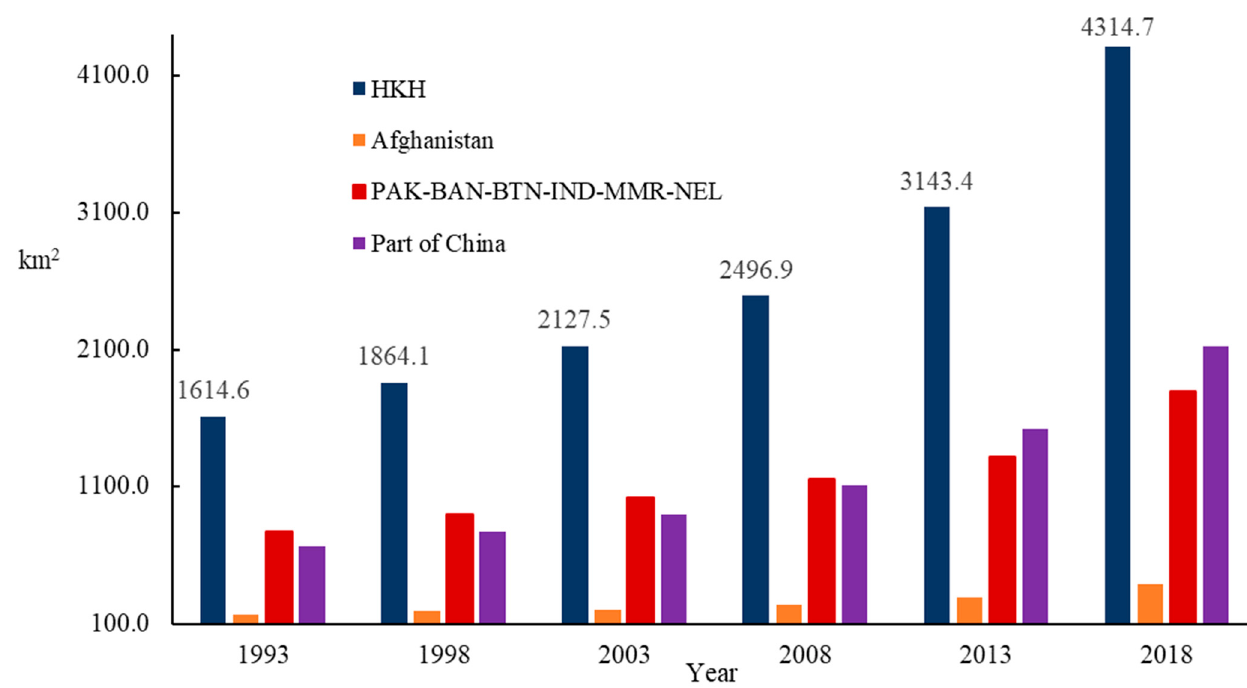
Figure 5. Areas of ISA for the entire region and three divided areas from 1993 to 2018. Table 2. Average annual growth rate of ISA from 1993 to 2018.